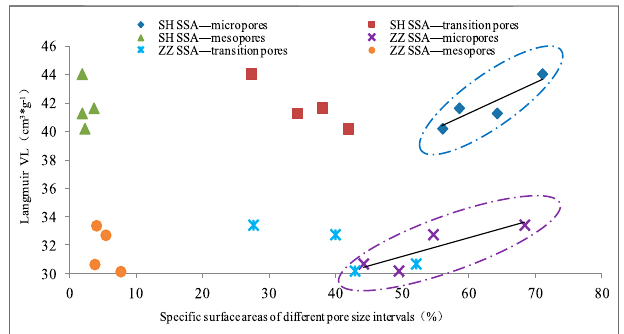
FIGURE 8 | Relationships between SSA and V L of different pore size.